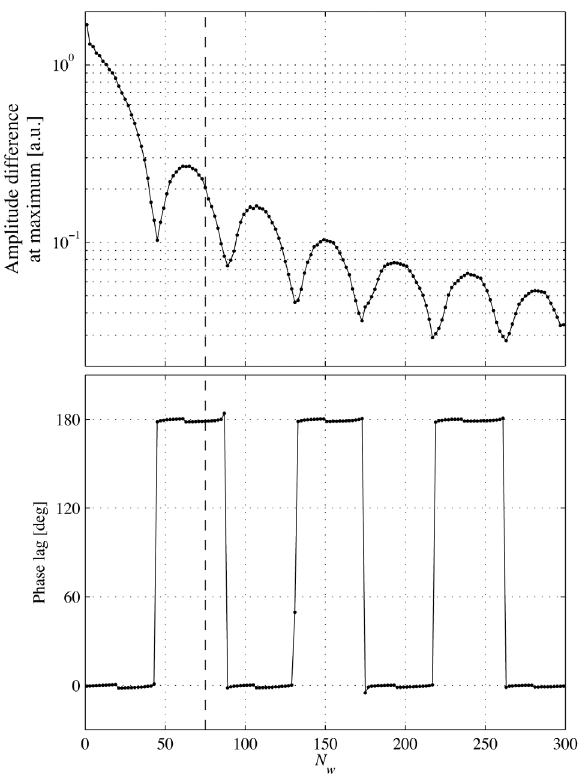
Figure 5. MAVG behaviour. Top: amplitude of the oscillation for different values of the window size N the expected signal and the original perturbation, for the same value of N . Dashed line corresponds to N w